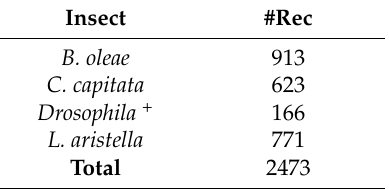
Table 2. Dataset composition.